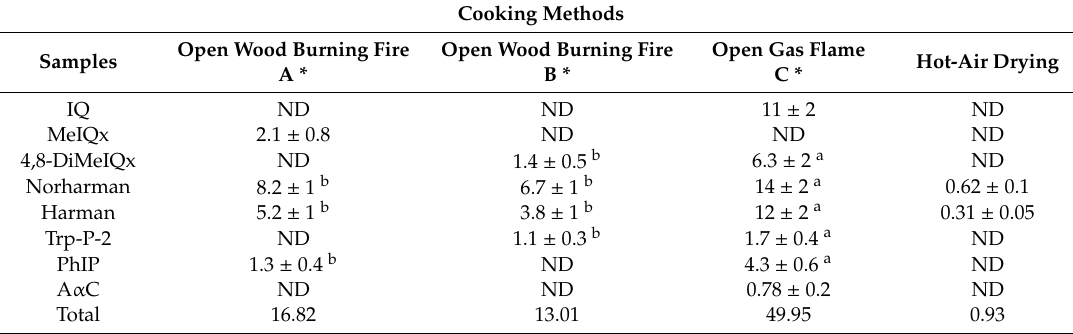
Table 2. The contents of HCAs in duck breast skin samples from supermarkets (ng / g, n =